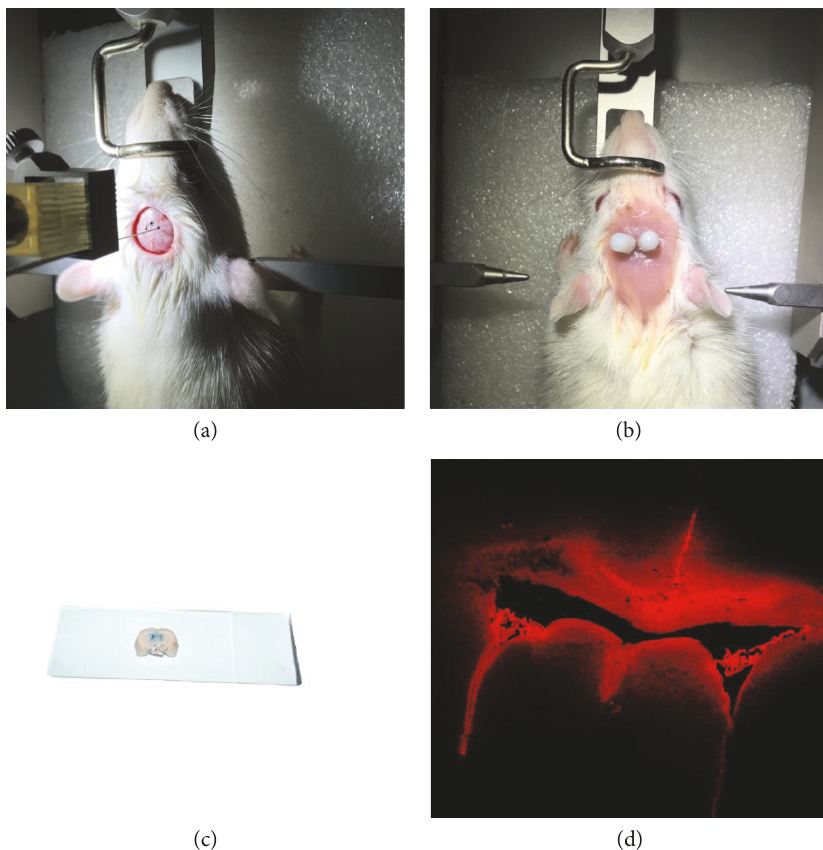
Figure 3: The e ff ectiveness and validity of ICV catheterization. (a) The fi xed position of ICV catheterization. (b) The rat subjected to e ff ective ICV catheterization. (c) The structure and morphology of bilateral paracele detected with the naked eye. The bilateral paracele was su ff used with blue substance after ICV injection of 1% Evans blue, suggesting the validity of ICV injection and ICV catheterization. (d) The structure and morphology of bilateral paracele screened under the fl uorescence microscope. The wall of the whole bilateral paracele, including frontal, occipital, temporal and inferior horn, was su ff used with Evans blue exhibiting red fl